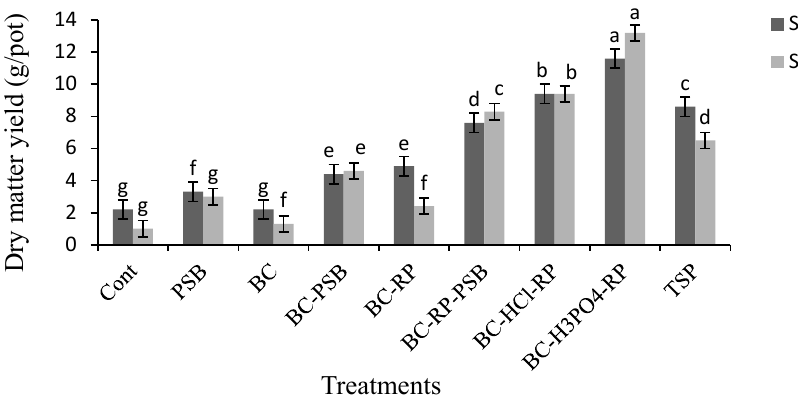
Figure 3. Effect of different treatments on dry matter yield of wheat. PSB: phosphate solubilizing Figure 3. E ff ect of di ff erent treatments on dry ma tt er yield of wheat. PSB: phosphate solubilizing